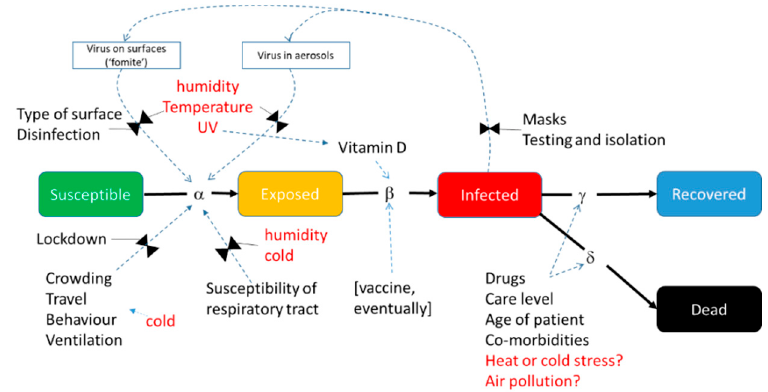
Figure 2. Environmental factors that have been suggested to influence a COVID-19-like disease, overlain on the structure of a generic SEIR-type compartment model to show the potential mechanisms of action.